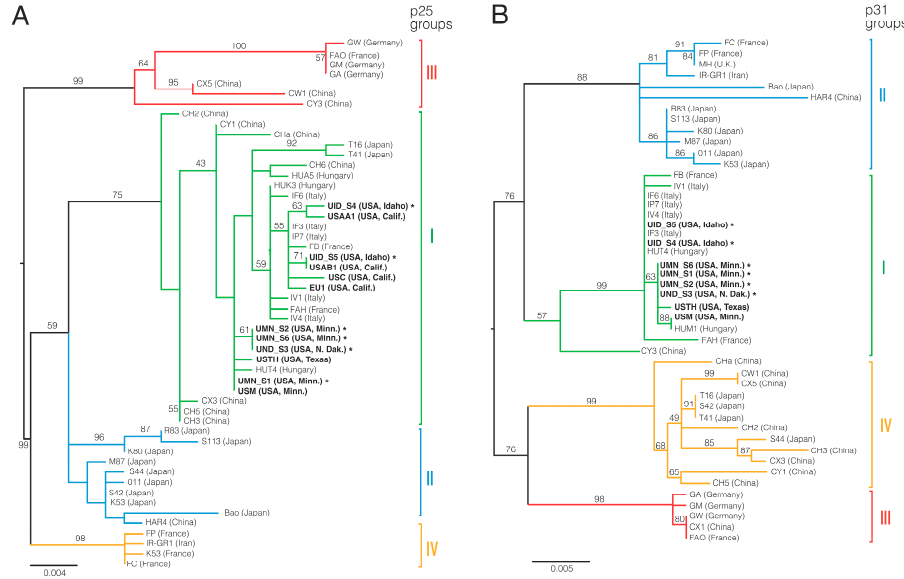
Figure 2. Relatedness of USA BNYVV to global isolates based on p25 and p31 gene sequences. Phylogenetic trees were inferred using Randomized Axelerated Maximum Likelihood (RAxML), using runtime calculated bootstrapping. ( A ) Coding sequence of p25 from 52 BNYVV strains and ( B ) coding sequence of p31 from 46 strains, coded on RNA3 and RNA4 of the BNYVV genome, respectively. Each tree was midpoint rooted, and ML support values are displayed for each branch with greater than 50% support. The four resulting groups in each tree were colored and indicated with solid bars shown to the right of each tree. The strain name is shown for each isolate along with the reported country of isolation in parentheses along with the state for US isolates. All US isolates are in bold. Sequences collected from this study are denoted with *.